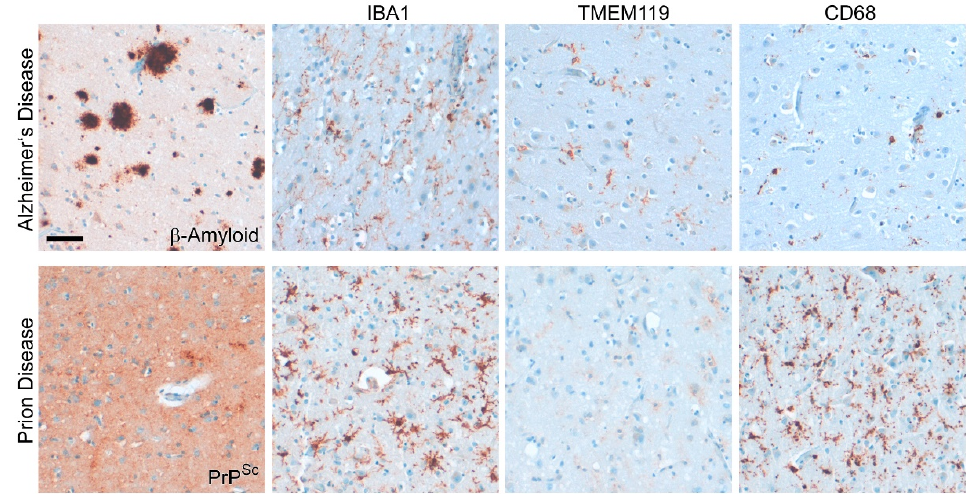
Figure 7. Disease-associated microglia profile differs between human sCJD and AD. Frontal cortex tissue of a sCJD patient and an age-matched AD patient show reactivity for the pan-microglia/macrophage marker IBA1, the microglial marker TMEM119, and the activation marker CD68 [97]. Deposits of misfolded proteins are shown for the respective antibodies against amyloid- β (AD) or PrP Sc (sCJD). Note that the deposition pattern of misfolded PrP Sc may vary considerably between CJD patients (see also Figure 6). In contrast to AD, microglia activation is more prominent and the microglial homeostasis marker is almost completely lost in sCJD [97]. Scale bar: 50 µ